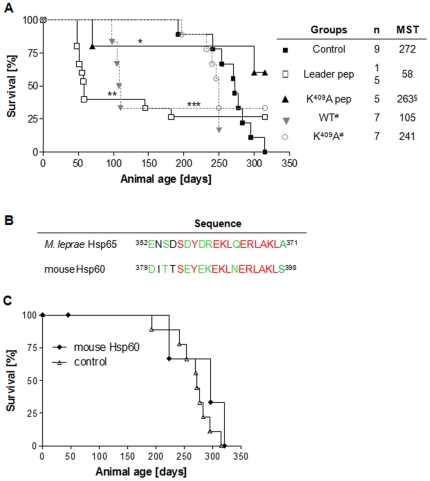
Effect of the Leader pep and K409A pep peptides and autologous Hsp60 inoculation on SLE.A) Survival of [NZBxNZW]F1 female mice [n = 5 to 15/group] inoculated with synthetic peptides at 45 day-old. §Estimate was limited to the largest censored time [315 day-old]. #Data from [16]. MST = Mean survival time. *p<0.05: K409A pep versus Leader pep; **p<0.01: Leader pep versus control group; ***p<0.001: WT versus control group. Results are representative of 2 independent experiments. B) Amino acid alignment of M. leprae Hsp65 and mouse Hsp60. Amino acid homology colors: Identical: red; strongly similar: green; different: black. C) Survival of [NZBxNZW]F1 45-day-old female mice [n = 5 to 6] inoculated with mouse Hsp60 [♦]; control group [Δ]. Results are representative of 2 independent experiments.